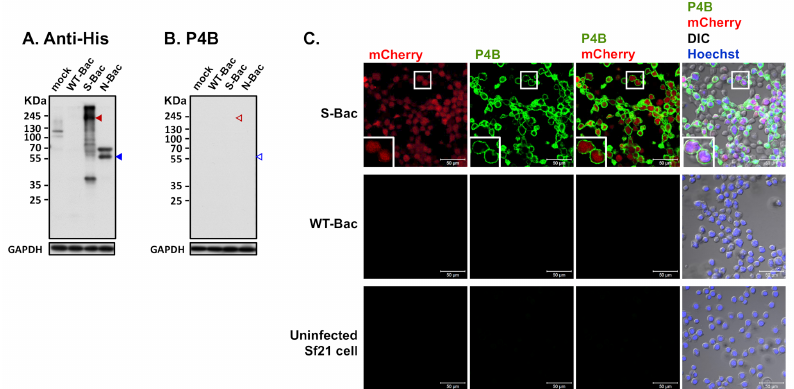
Figure 5. Detection of PEDV S protein by a neutralizing mAb, P4B. ( A ) Western blot analysis using anti-His antibody in uninfected Sf21 cells (mock) and in insect cells infected by WT-Bac, S-Bac, and N-Bac. Anti-His antibody detected the expression of S (red arrowhead) and N (blue arrowhead) in insect cells infected with S-Bac and N-Bac, respectively. Primary antibody: anti-His antibody (1:5000). Secondary antibody: goat anti-mouse IgG conjugated to HRP (1:5000). ( B ) Western blot analysis using P4B antibody in the same sample set of Figure 5A. Primary antibody: P4B antibody (1:1000). Secondary antibody: goat anti-mouse IgG conjugated to HRP (1:5000). ( C ) IFA to determine hybridization of P4B antibody with Sf21 cells infected with S-Bac, WT-Bac, and uninfected Sf21 cells. Signals of mCherry (derived from S-Bac infection), P4B antibody (green), and Hoechst counterstaining (blue) are shown. DIC: differential interference contrast microscopy. Insets: magnifications of the single cell marked by white boxes. Primary antibody: P4B antibody (1:1000). Secondary antibody: Alexa Fluor 488 goat anti-mouse IgG (1:200). Bar: 50 µ